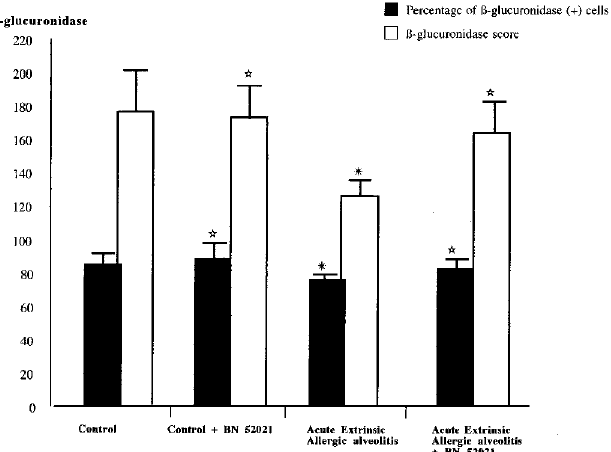
FIG. 3. In vivo effect of BN52021 on intracellular lysosomal enzymes. Data are mean ± SD of six guinea pigs/group and were analysed by one-way analysis of variance and multiple mean comparison test. Asterisks ( w ) represent significant differences ( P < 0.05) with respect to control group and stars ( q ) significant differences ( P < 0.05) with respect to the acute EAA group.